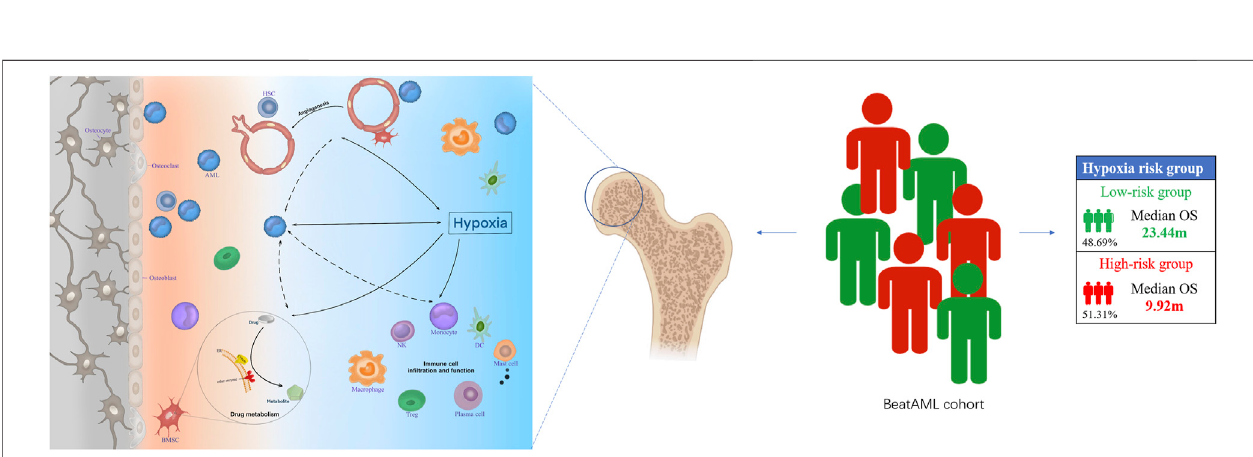
FIGURE 7 | The hypoxia-related mechanisms that are involved in a poor prognosis of acute myeloid leukemia (AML) patients. Hypoxia may affect the prognosis of patients with AML by affecting angiogenesis, drug metabolism, and bone marrow immune microenvironment.